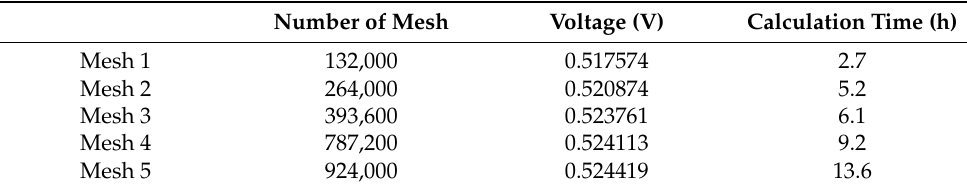
Table 4. Results of mesh independence study at 2400 mA cm − 2 .